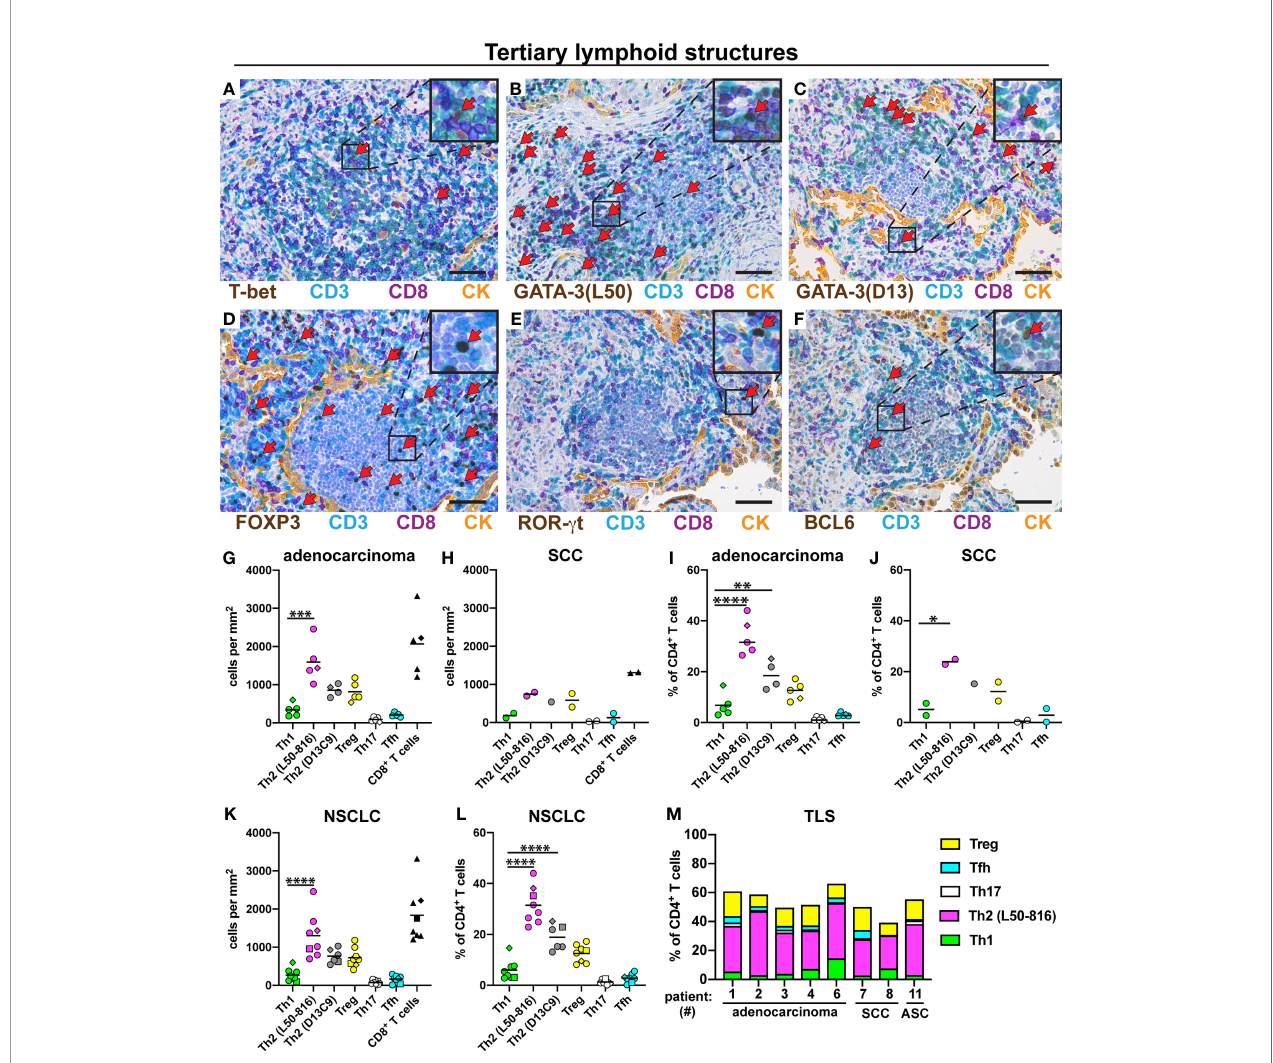
FIGURE 4 | Quanti fi cation of Th subsets and CD8 + T cells in tertiary lymphoid structures (TLS). Tumor sections from 8 NSCLC patients [5 adenocarcinoma, 2 squamous cell carcinoma (SCC), and 1 adenosquamous carcinoma (ASC)] were immunostained and cells were quanti fi ed in TLS located at the tumor periphery. (A – F) Representative images of stained TLS. Boxed areas are enlarged and presented as corner insets. Red arrows indicate positively stained cells for each Th subset. (A) Th1 cells (T-bet + CD3 + CD8 - ). (B, C) Th2 cells (GATA-3 + CD3 + CD8 - ) detected by mAb clones L50-816 and D13C9, respectively. (D) Treg cells (FOXP3 + CD3 + CD8 - ). (E) Th17 cells (ROR- g t + CD3 + CD8 - ). (F) Tfh cells (BCL6 + CD3 + CD8 - ). (G – M) Quantitative data for T cell subsets in TLS. (G) Number of cells per mm 2 in TLS of adenocarcinoma, or (H) SCC. (I) Percentage of each Th subset (of all CD3 + CD8 - Th cells) in TLS of adenocarcinoma, or (J) SCC. (K) Pooled cell density data in TLS for all NSCLC patients. (L) Pooled NSCLC data for Th percentages in TLS. (M) Th subset composition in TLS (as percent of all CD3 + CD8 - cells) for each patient analyzed. Each symbol in the graphs represents one patient and black lines indicate mean values. The square symbol indicates the adenosquamous carcinoma patient. The rhombus symbol ( ♦ ) indicates the never-smoker patient. Statistical analysis was performed using one-way ANOVA with Bonferroni´s post-hoc test. *p<0.05, **p<0.01, ***<0.001, ****p<0.0001. CK, cytokeratin. Original magni fi cation, 400x. Scale bars, 50 m